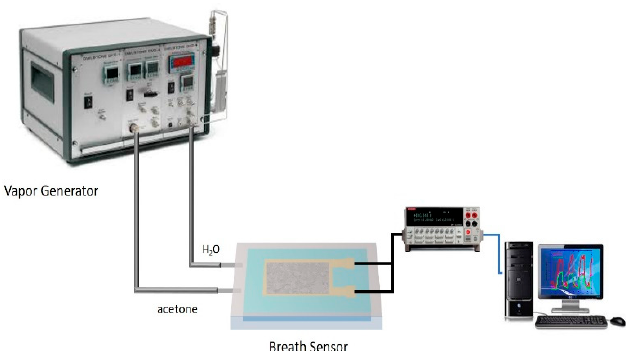
Figure 1. Diagram showing the acetone testing system. Acetone and humidity are generated by the Owlstone vapor and humidity generator and delivered into the sensor testing box.